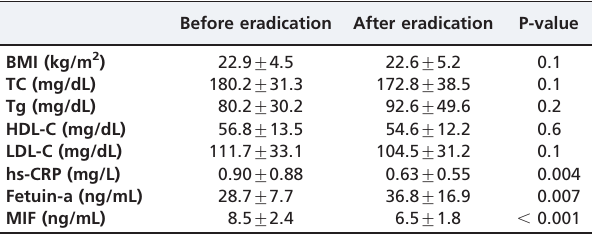
Table 2 - Clinical and laboratory characteristics of patients before and after H. pylori eradication. Results are presented as mean ¡